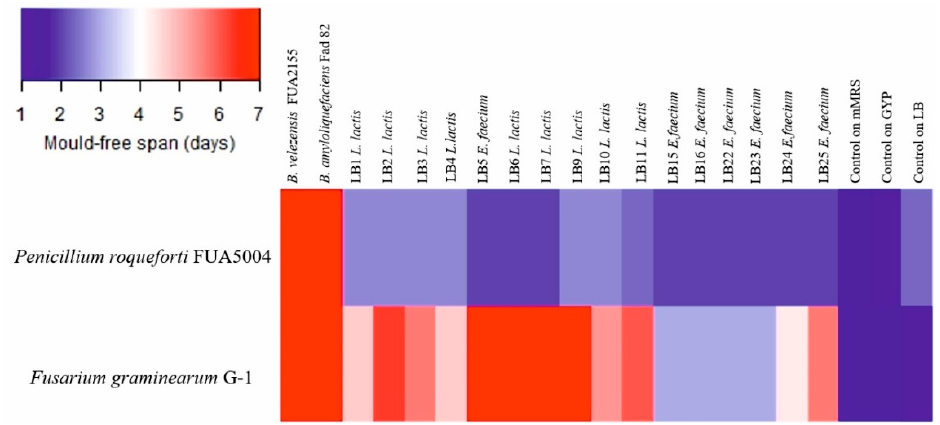
Figure 4. Heatmap representing the average of the mold-free days ( n = 3). Controls on mMRS, GYP, and LB broths refer to wells containing just broth acidified to pH 4.5 and fungal spore suspension. Bacillus velezensis FU2155 and Bacillus amyloliquefaciens Fad82 were cultured in LB broth. LAB were cultured keeping the same culture medium used for the isolation step: Lactococcus lactis and Enterococcus faecium LB5 were cultured in mMRS broth; the remaining E. faecium were cultured in GYP broth.